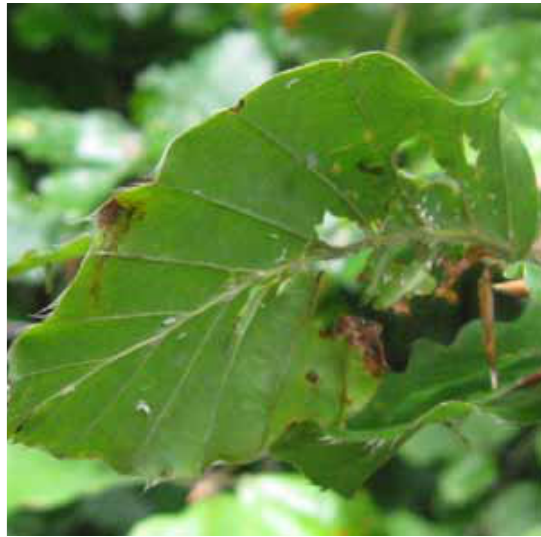
FIGURE 3 Beech aphids